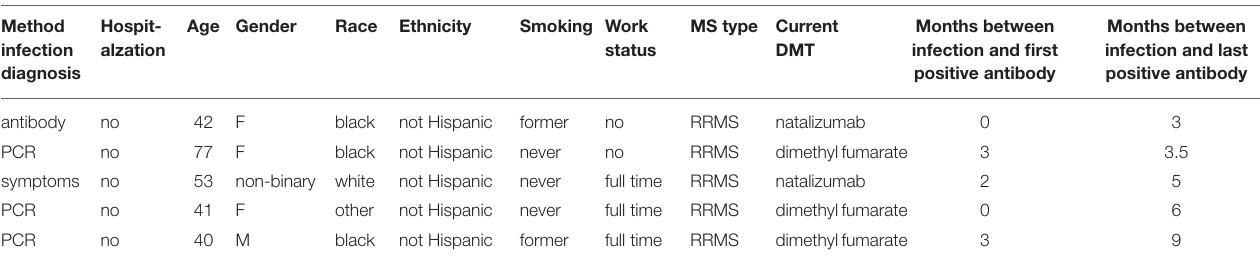
TABLE 3 | Patient characteristics with persistently positive COVID-19